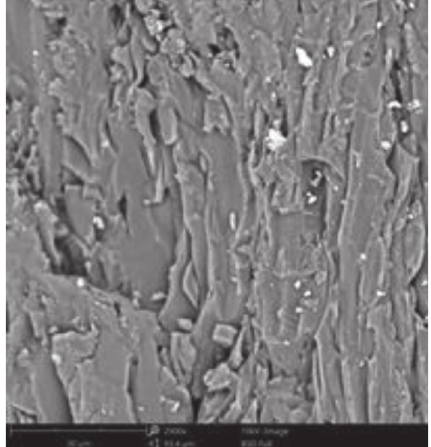
Figure 1: SEM diagram of rock